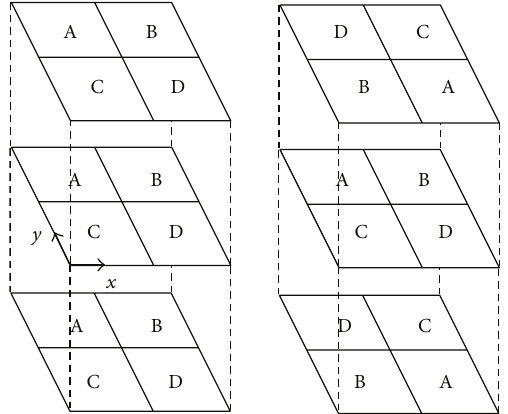
Figure 13: 3D 4 × 4 i-MIMO DAS coverage. Left: noninterleaved coverage solution. Right: coverage solution with branch interleaving between different